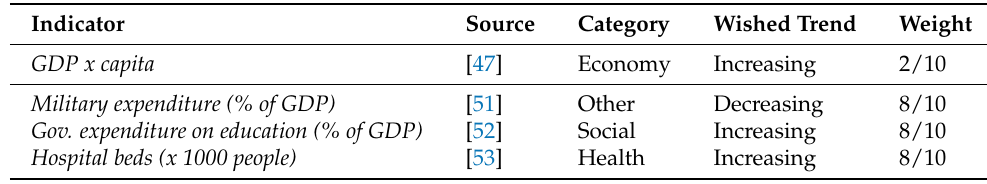
Table 3. Raw data and parametrization (Case Study 2).